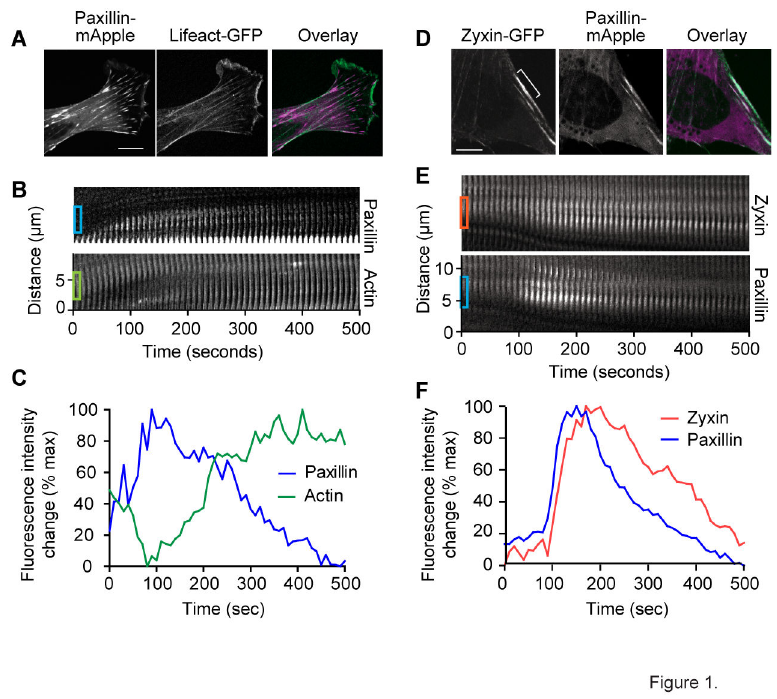
Figure 1. Stress fiber strain sites recruit paxillin. (A) The localization of paxillin is not restricted to focal adhesions. Time lapse micrographs taken at 10 second intervals of live mouse fibroblasts expressing paxillin-mApple and Lifeact-GFP (A and B) or zyxin- GFP and paxillin-mApple (D and E). Kymograph (B) and average intensity plotted over time (C) of boxed regions from kymograph (B) showing recruitment of paxillin and concurrent thinning actin. (D) Still frames showing overlap of paxillin and zyxin at a strain site. Kymographs (E) showing progression of zyxin and paxillin recruitment in the white bracketed region of (D) over time. Intensity plot (F) of the boxed regions on the kymograph. Scale bar=10um. doi: